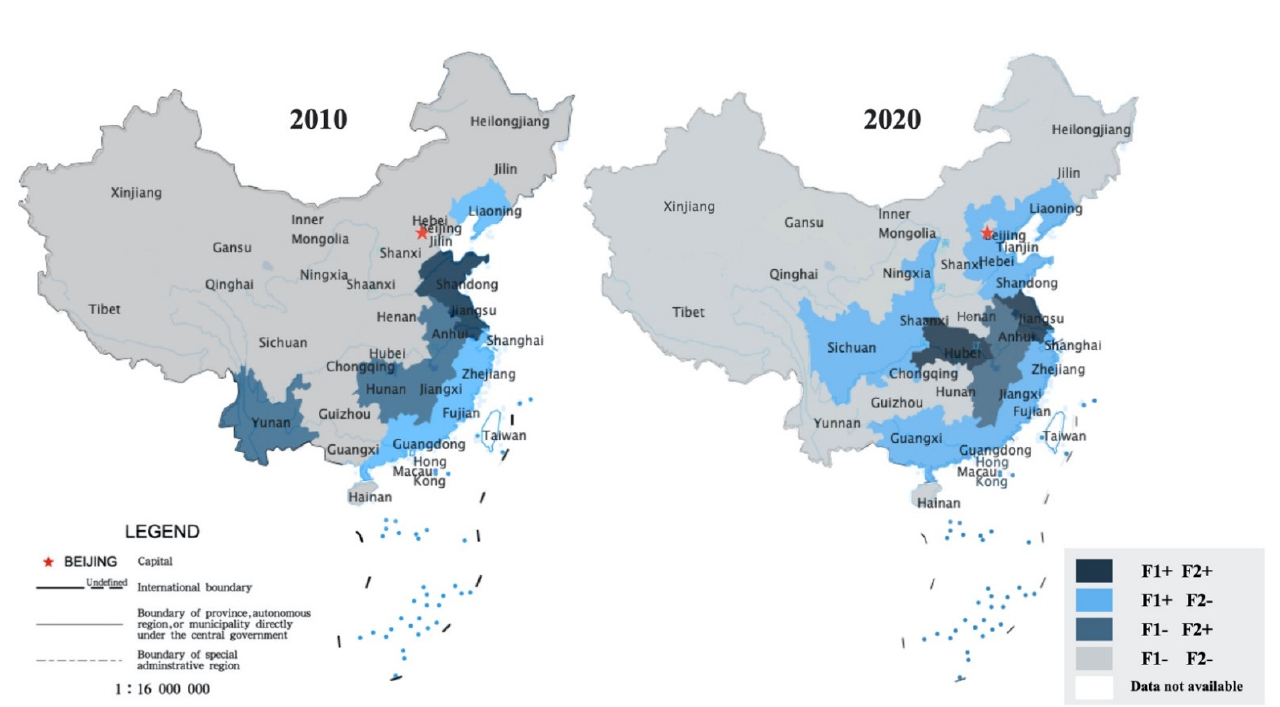
Figure 4. Changes in the evaluation of the comprehensive environmental and income of China’s regions. The Chinese map was generated by the standard map online service, URL link: http://bzdt.ch.mnr.gov.cn (accessed on 9 May 2022)).